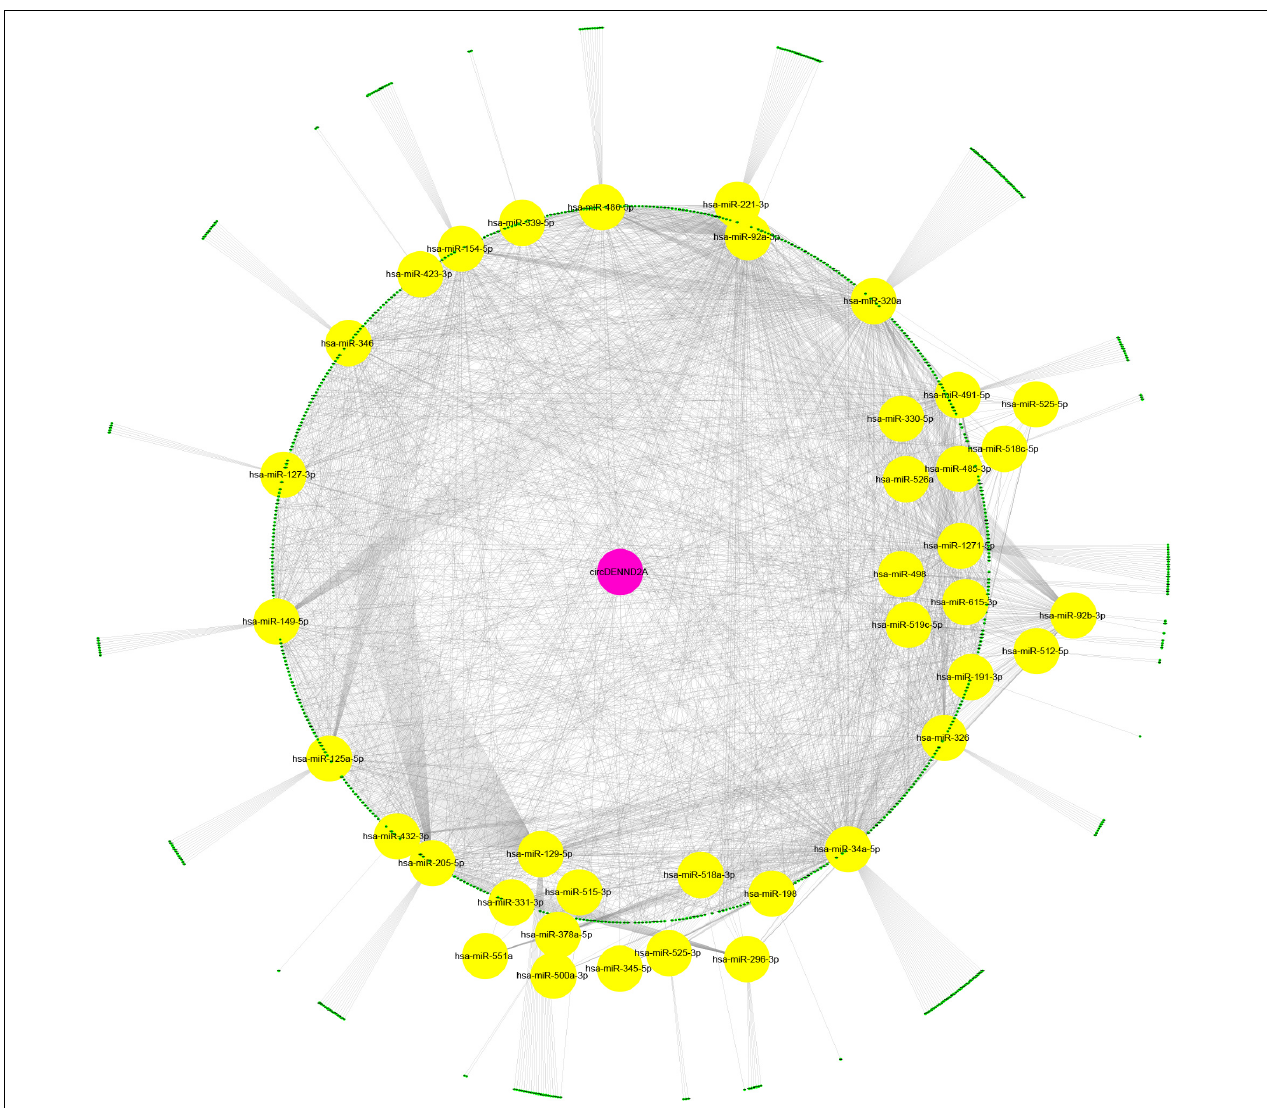
FIGURE 3 | Construction of circDENND2A associated ceRNA network. CircDENND2A associated ceRNA networks included 39 miRNAs and 867 differently expressed mRNAs. Purple node, circDENND2A; yellow nodes, miRNAs; blue nodes, mRNAs. ceRNA, competing endogenous RNA; miRNA, microRNA.